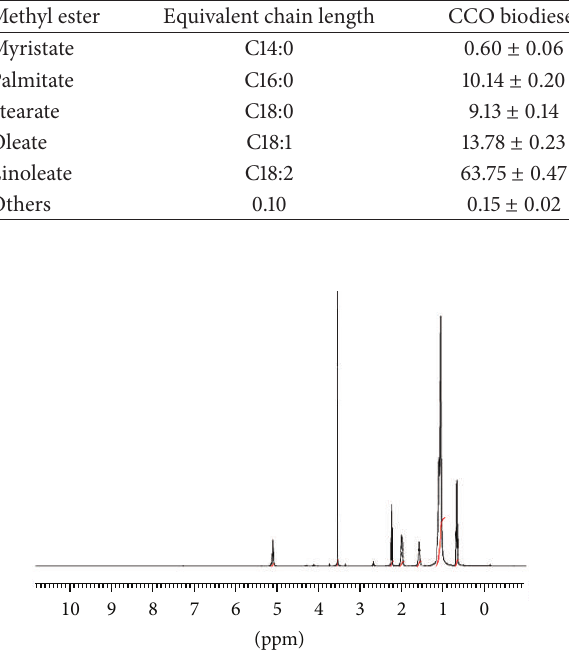
Figure 15: Proton NMR spectrum for CCOME content. A conver- sion of 95.4% obtained after 105 min at 150 ∘ C, 3.6 wt% of recycled DSIMHSO 4 , and 12 :1 molar ratio of methanol/CCO.